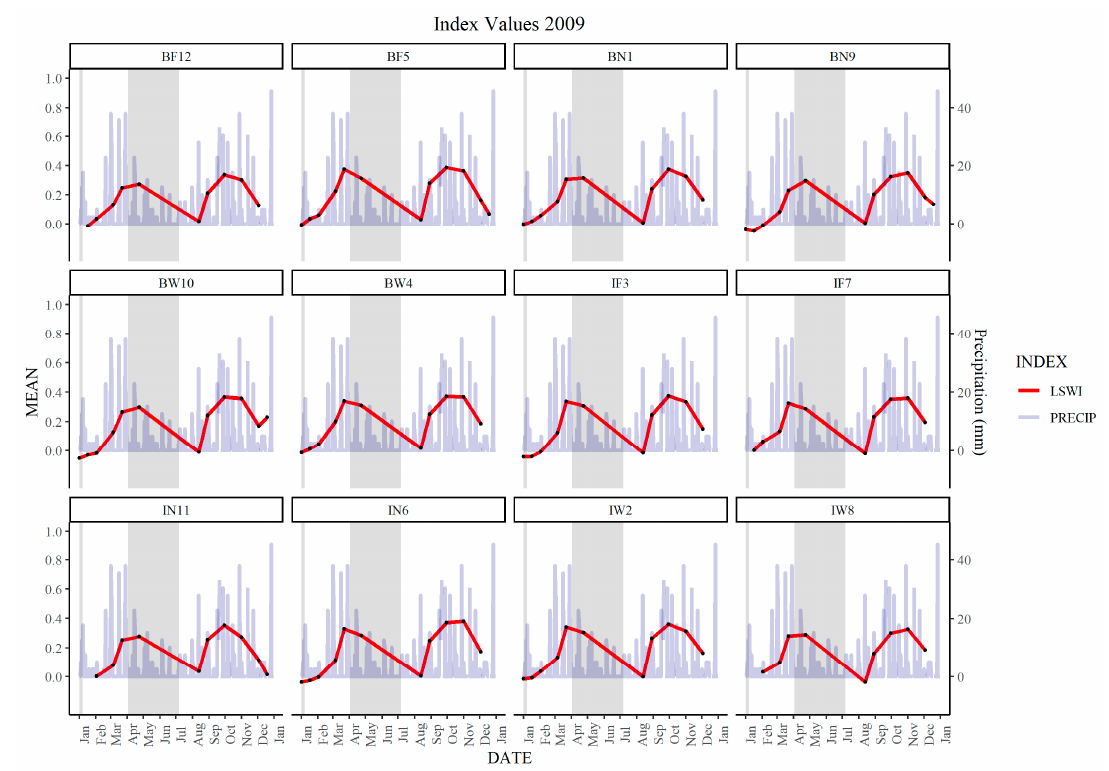
Figure 6. Time series charts for 2005–2009 showing land surface water index (LSWI) values and precipitation data overlaid with the grazing periods, shown in gray. Negative values indicate a drought state. Summary statistics can be found in Supplemental Table S1. Each paddock was named based on if broiler litter (B) or inorganic (I) fertilizer was applied and if the tall fescue type was free of endophytes (F), novel–tall fescue MaxQ type with novel endophytes (N), or wild type endophytes (W), with two paddocks of each combination type within the study area (i.e., BF, IF, BN, IN, etc.).